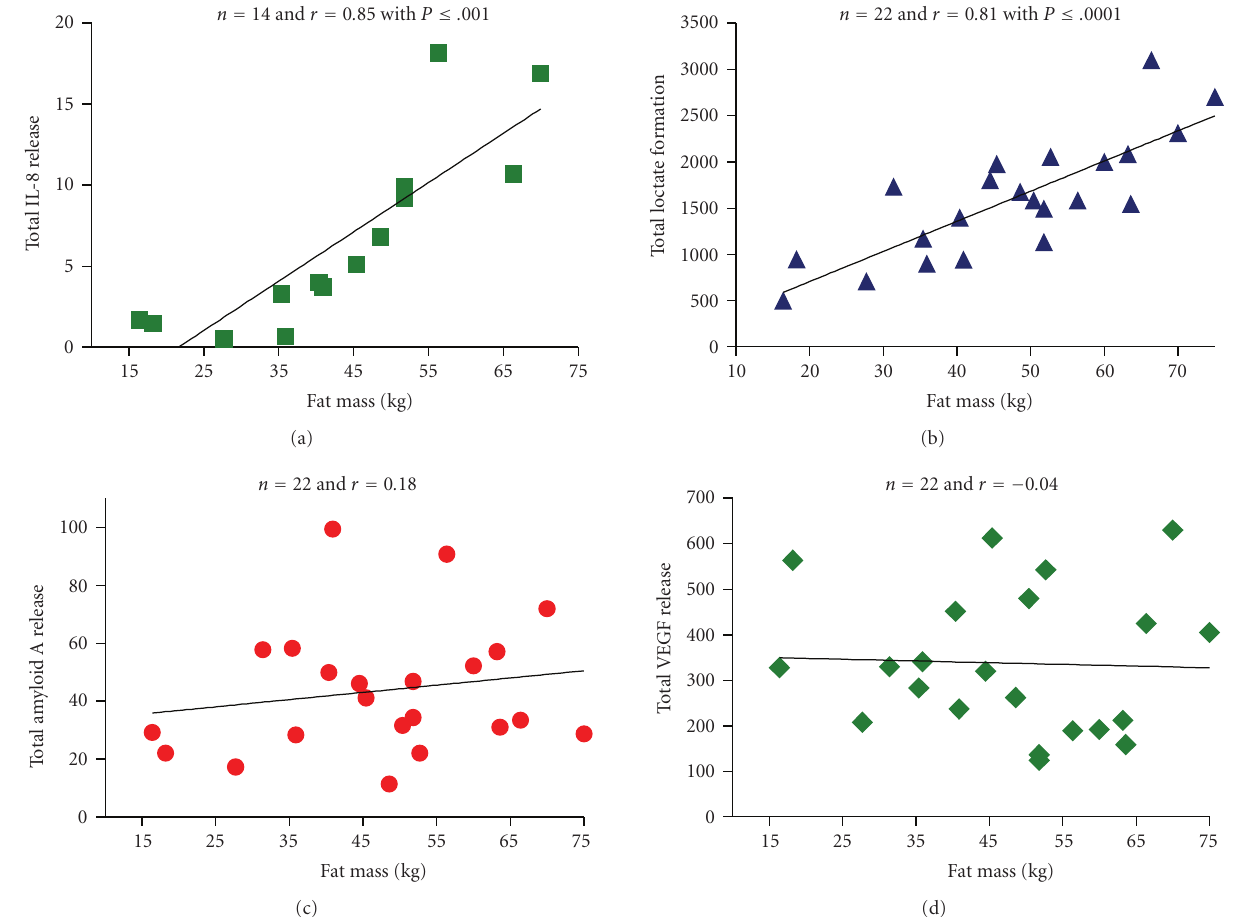
Figure 4: Correlation between total release of IL-8, VEGF, Amyloid A, and lactate by adipose tissue and total fat mass. The total release was calculated by averaging release over 48 hours per kg by explants of visceral omental and subcutaneous adipose tissue from 14 [IL-8] or 22 di ff erent women (lactate, amyloid A and VEGF) and multiplying by the total fat mass. Tissue samples were from the same women described by Fain et al. [42]. The Pearson correlation coe ffi cients ( r ) are shown on the figure and the P value if statistically significant with a P < . 05.